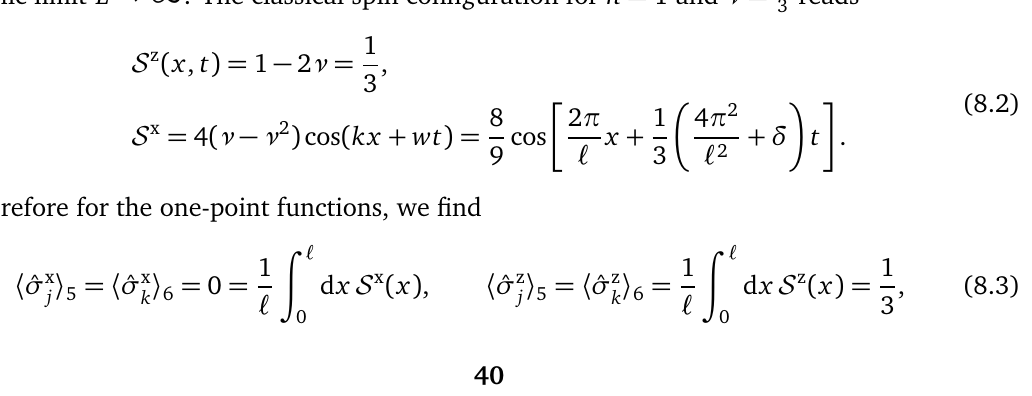
〉 (shown in green circles for ˆ σ x j + n j 〉 ˆ σ z j j + n